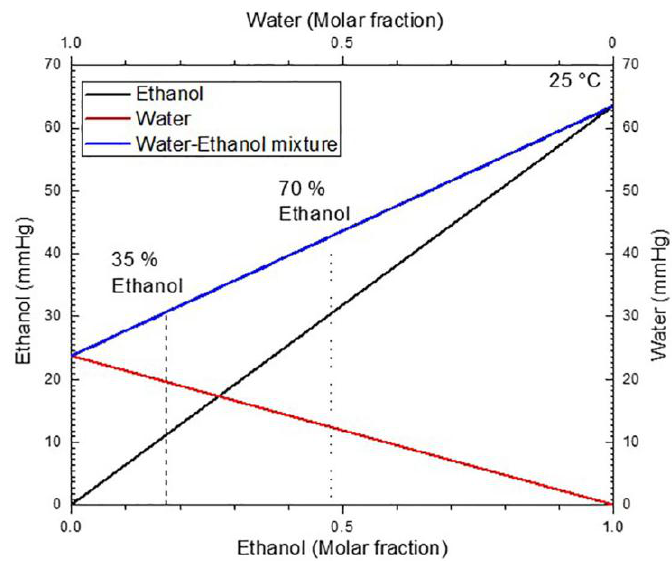
Figure 5. Vapor pressures as a function of the molar fraction for ethanol (black line), water (red line), and the mixture (blue line) at 25 C. Vapor pressure of the mixture for ethanol concentrations in a volume of 35% and 70% are indicated (dot lines).